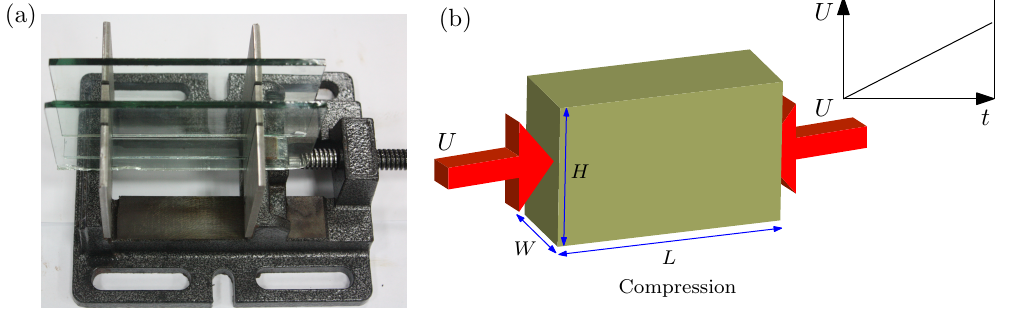
Figure 1. ( a ) in-house loading apparatus to realize the exact plane strain condition under uniaxial compression; ( b ) schematic of the monotonic uniaxial compression. The size of the specimen is denoted by length L , height H and width W .